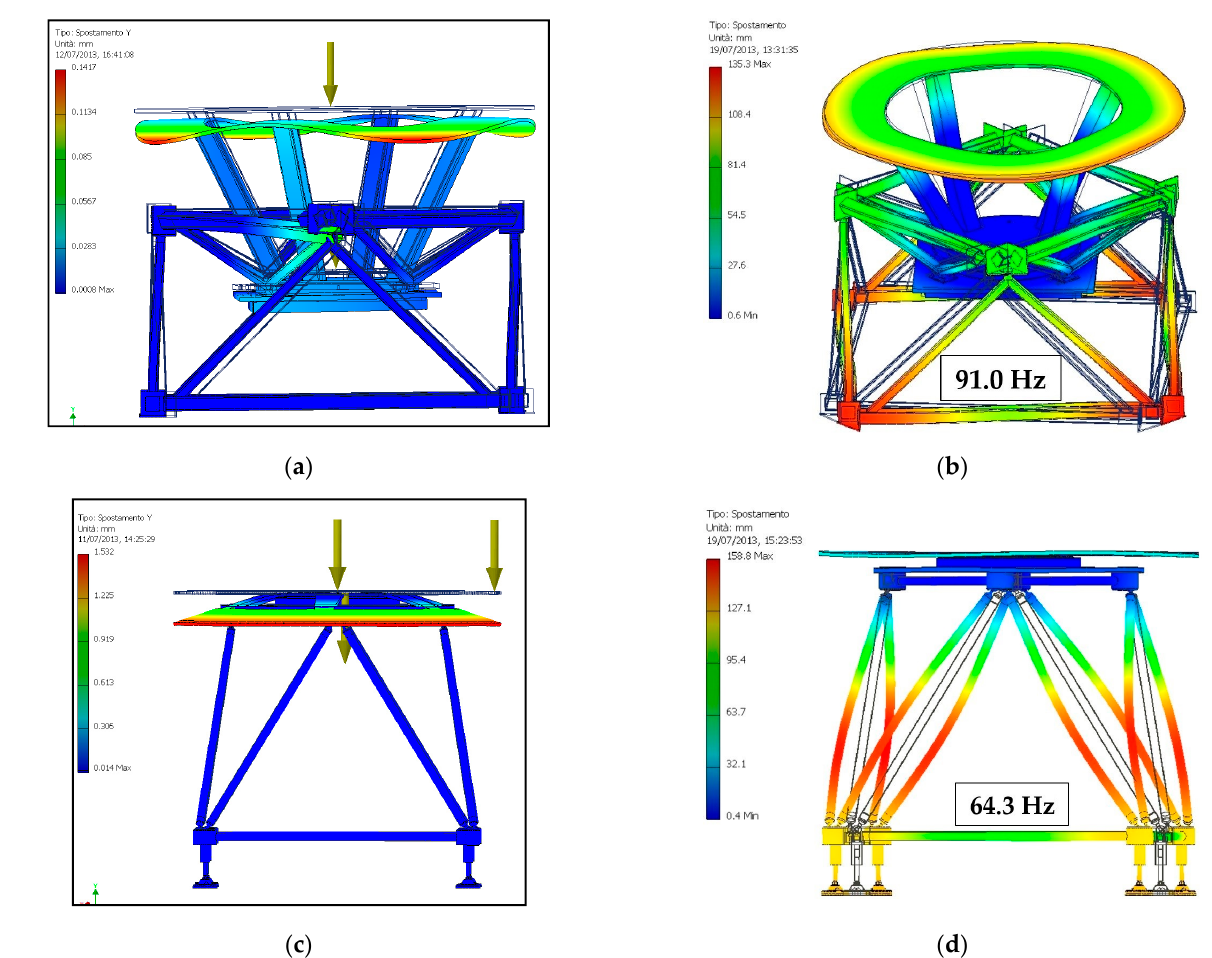
Figure 9. Displacement ( a ) and first vibration mode ( b ) of the base [21]; displacement ( c ) and vibration mode ( d ) of the corresponding FLEX base.